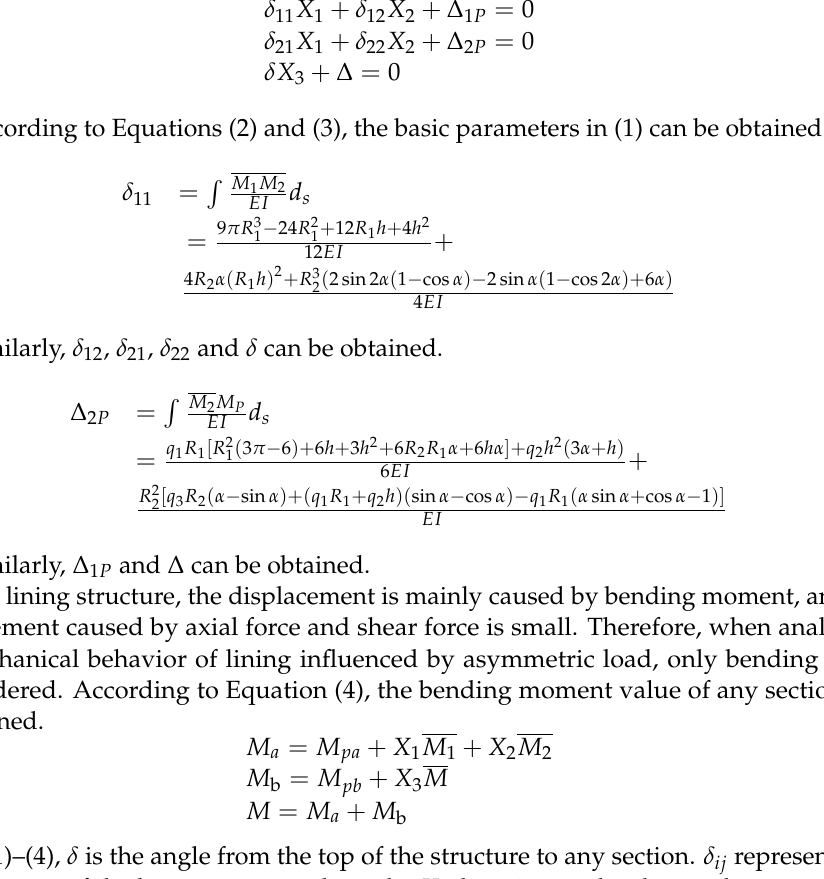
Figure 4. Mechanical calculation model of lining under asymmetric force. Half of the antisymmetric part is taken for analysis, as shown in Figure 4c, and it is simplified to a statically indeterminate structure. Releasing the support constraint at point A of the vault, and replacing it with the redundant unknown force X 3 , which represents the vertical support reaction (F ay ) at point A, as shown in Figure